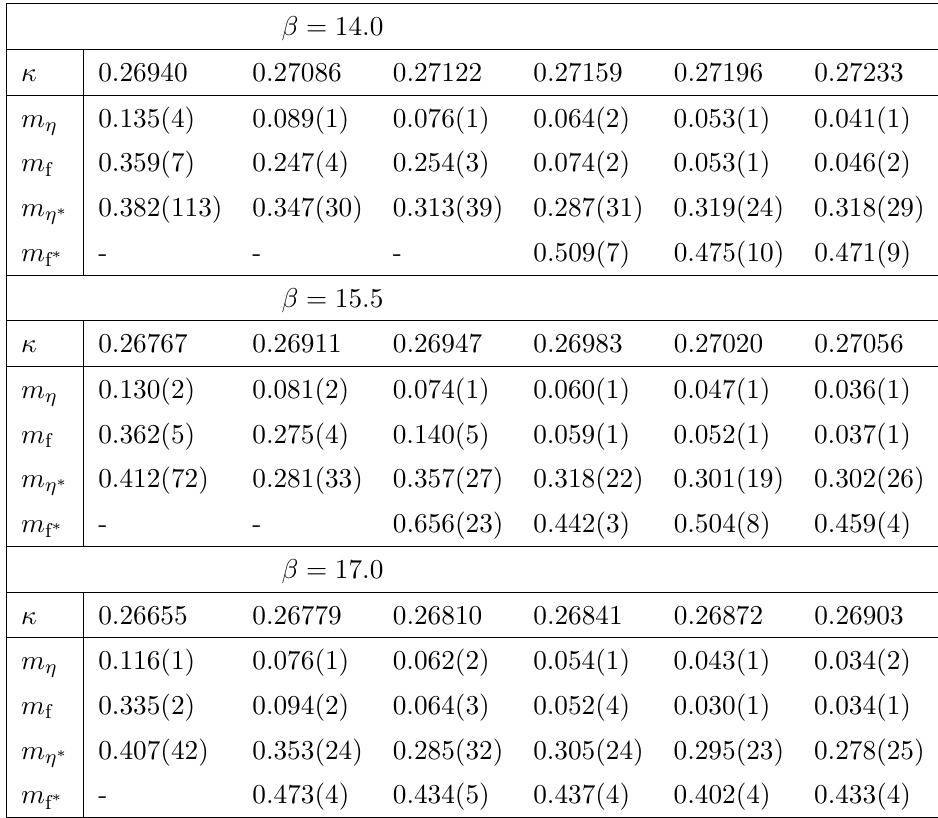
Table 8. Masses of the (cid:17) - and f-meson ground and excited